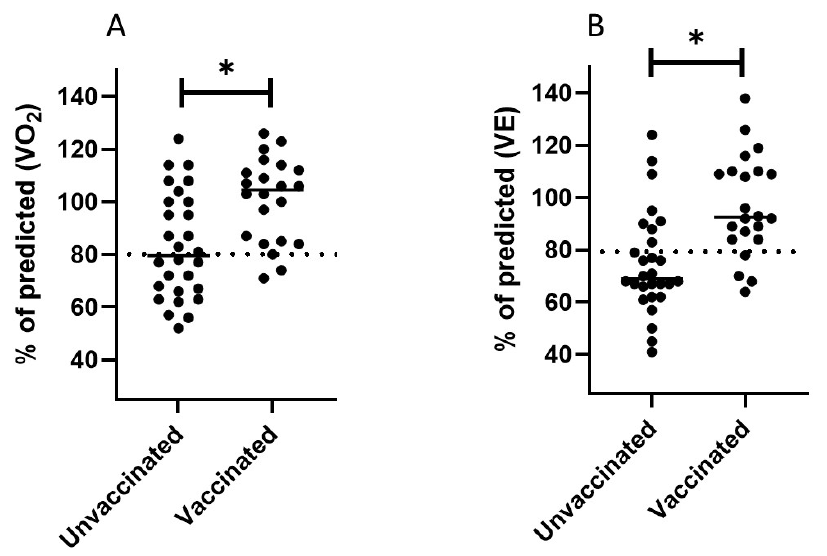
Figure 1. VO 2 /Kg peak ( A ) and peak heart rate ( B ) among COVID ‐ 19 unvaccinated vs. vaccinated patients previously infected with SARS ‐ CoV ‐ 2 (* p < 0.05).